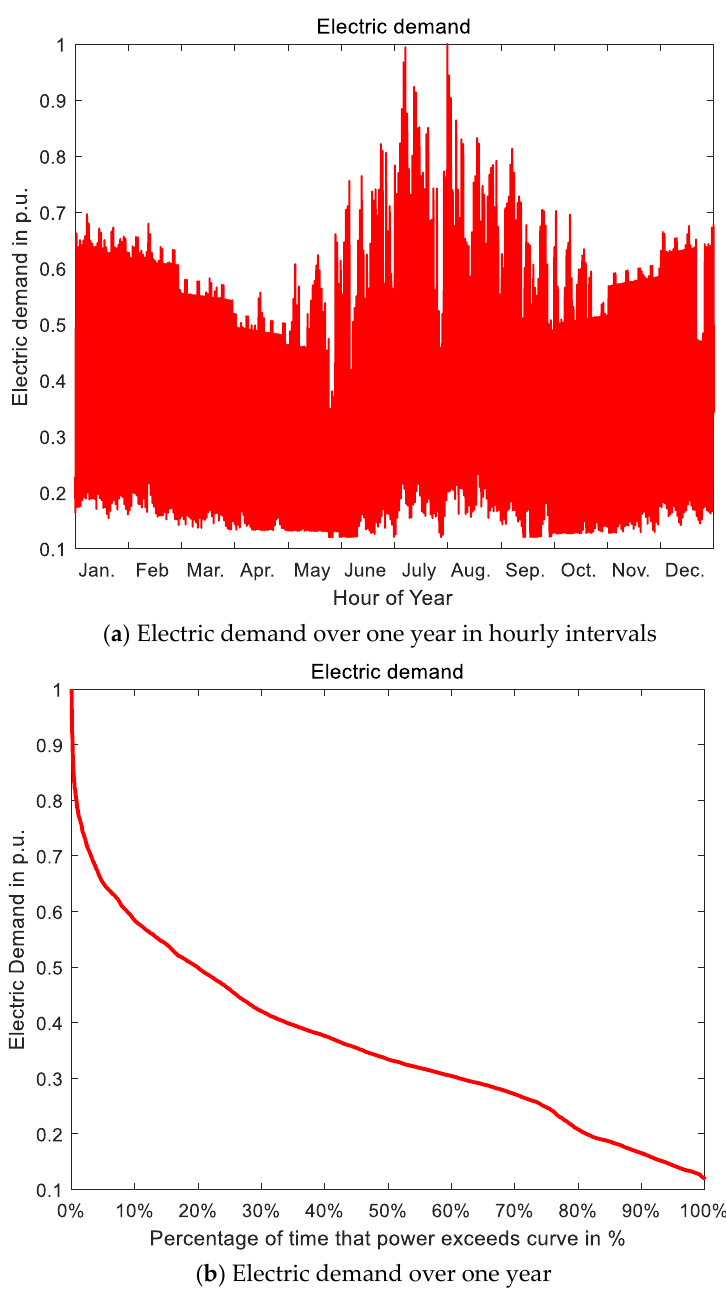
Figure 9. Yearly electric load profiles for the Atlanta area.